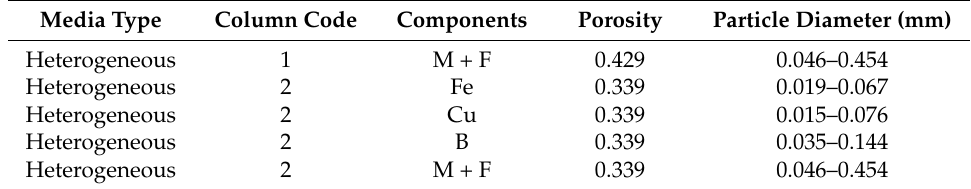
Table 2. Experimental configurations and specifications of the applied heterogeneous systems.